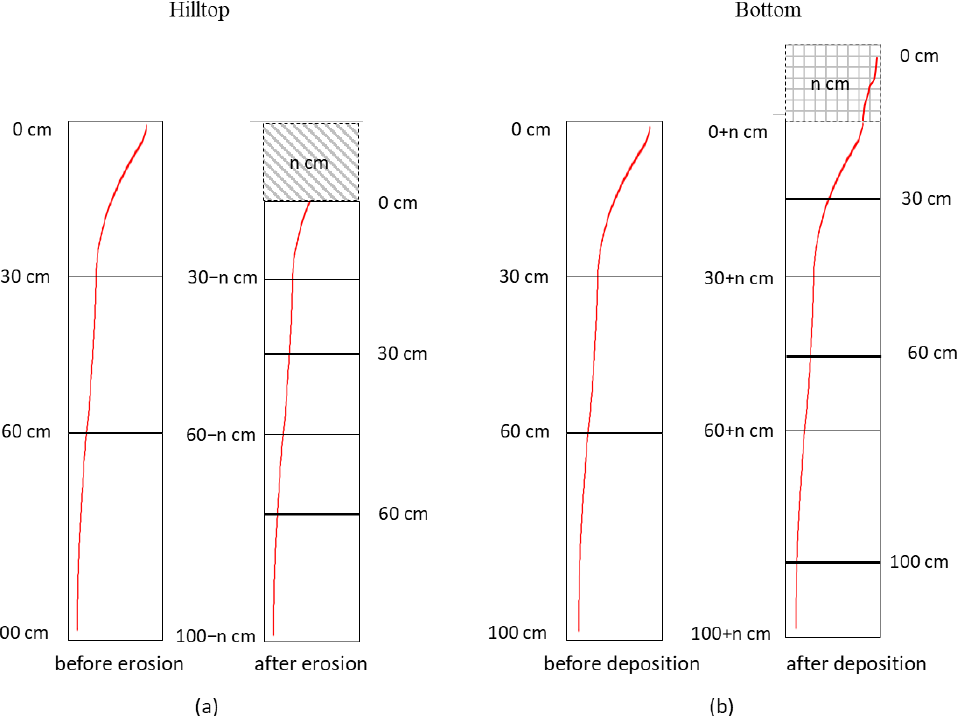
Figure 3. A diagram for the erosion of a profile at hilltop ( a ) and deposition of a profile at the bottom ( b ). The red line stands for SOC. The layer with grey slashed lines stands for the eroded soil and crossed lines for the deposited soil.